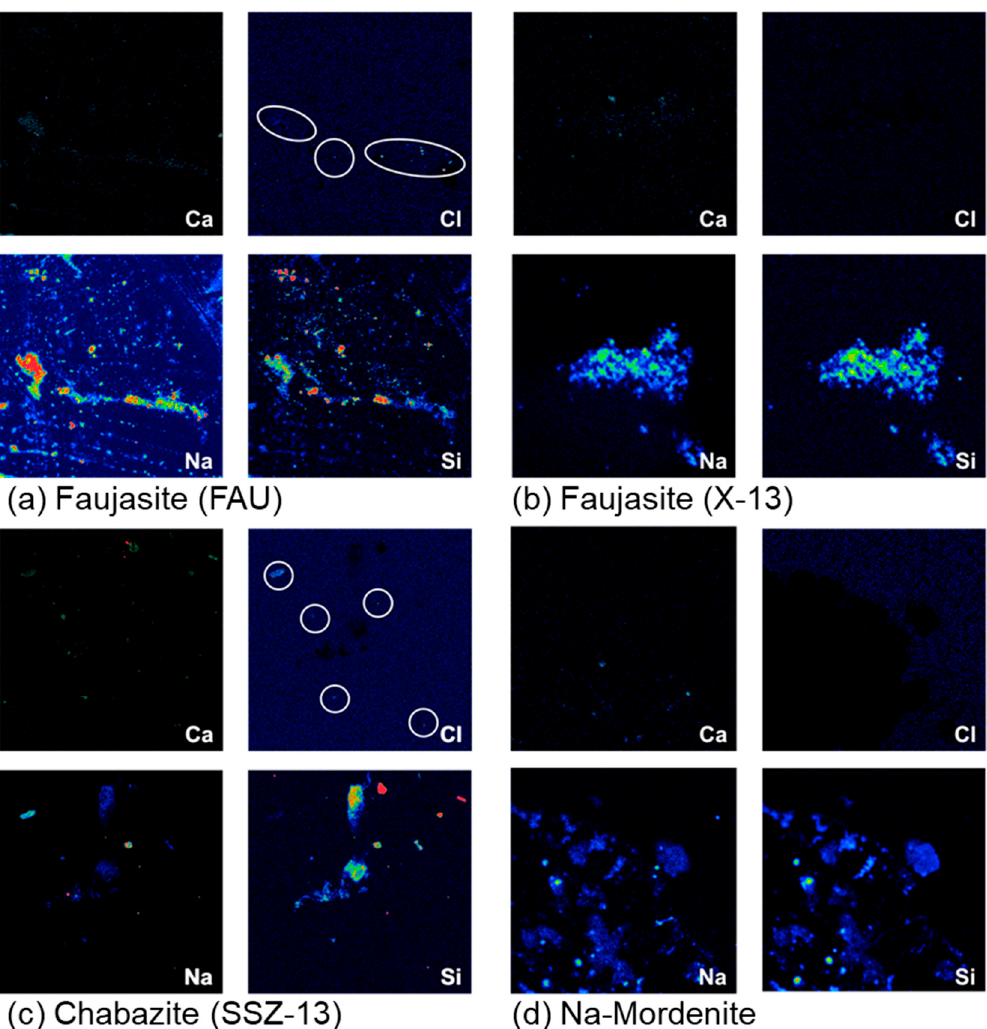
Figure 2. WDS (wavelength-dispersive X-ray spectroscopy) elemental composition maps of chloride-exposed ( a ) faujasite (FAU), ( b ) faujasite (X-13), ( c ) chabazite (SSZ-13), and ( d ) mordenite (Na-Mordenite).